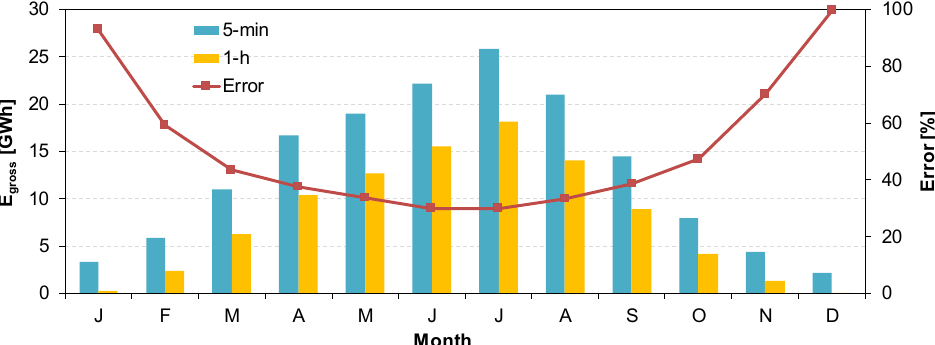
Figure 9. Yearly production of gross electric energy obtained with 5 min and 1 h simulation time steps.